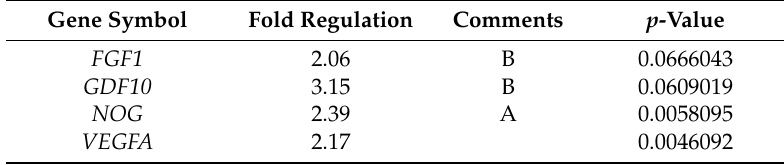
Table 4. Genes up-regulated after 24 h of stimulation with particles by at least a factor of 2 (normalization of C t -values with GAPDH). At a significance level of 0.0006 (adjusted for multiple testing) no significant up-regulation was found, A = in either the control or the test sample, the average C t is high (>30 cycles) B: the relative expression level is low ( C t > 30, in both control and test samples). Gene Symbol Fold